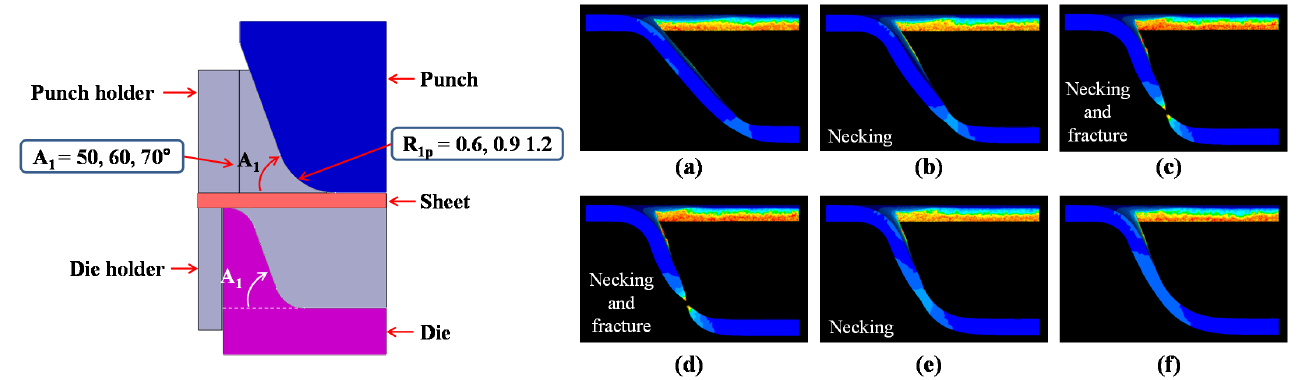
Figure 9. Design parameters used in FE analysis of one-stage forming and simulation results according to the design parameters: slope angle of ( a ) 50°, ( b ) 60°, and ( c ) 70° and corner radius of ( d ) 0.6 mm, ( e ) 0.9 mm, and ( f ) 1.2 mm.